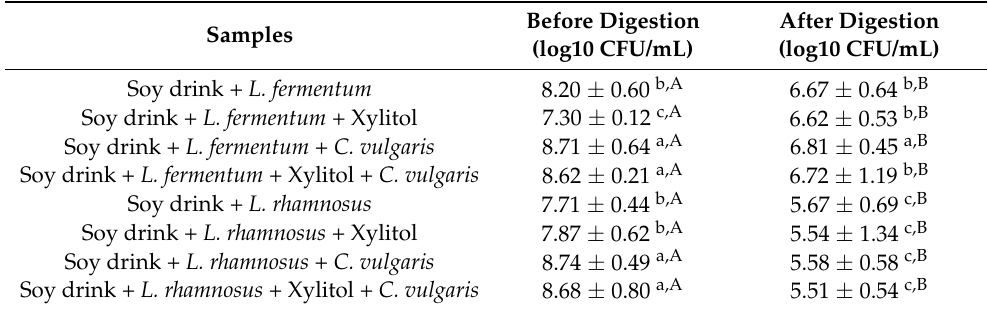
Table 2. Viable counts (log10 CFU/mL) of probiotic bacteria in different treatments during storage time. Samples